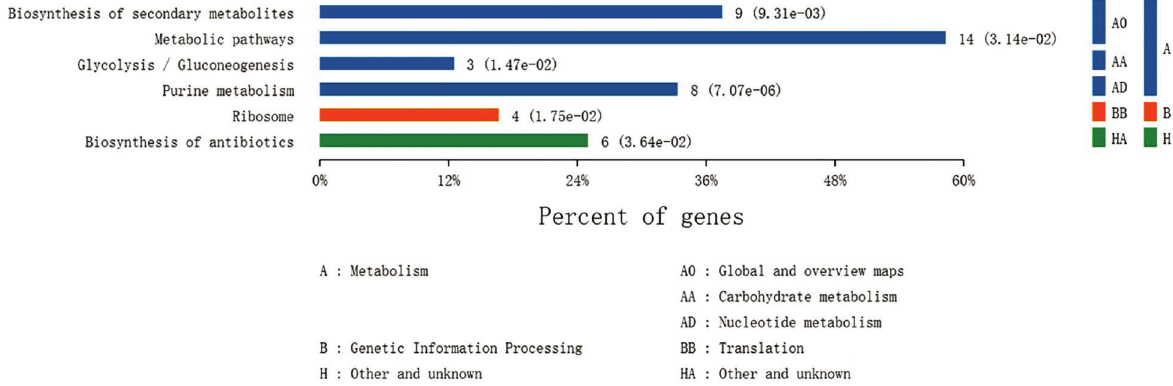
Figure 4. KEGG pathway enrichment analysis of differentially expressed proteins in the multidrug resistance isolate strain of C. perfringens . Differentially expressed proteins were categorized according to their gene ontology terms and in each category the number of proteins and their P-values are shown in the graph. The X-axis shows the percentage of differentially enriched